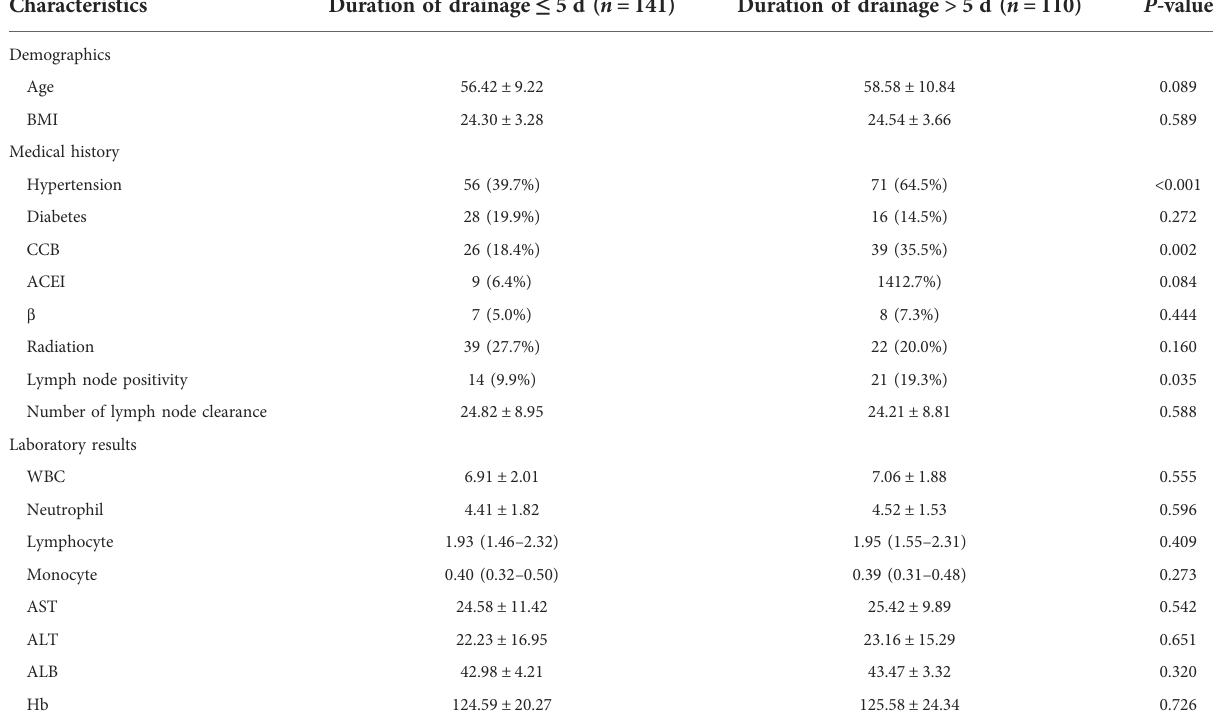
TABLE 5 Patient characteristics for duration of drainage.